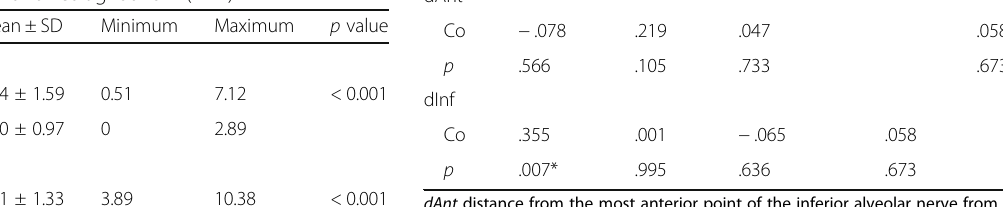
Table 3 Comparison of average distance of dAnt and dInf between prognathism and retrognathism (mm)